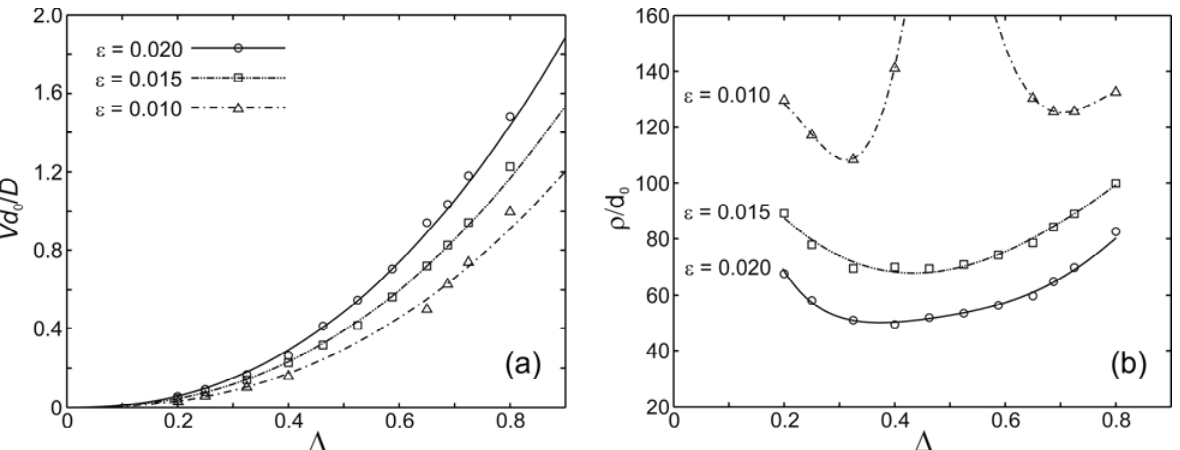
Figure 3. Calculated operating point parameter, σ *, as predicted by the phase field model as a function of undercooling and anisotropy strength. At ε = 0.01 stable dendritic growth is not observed in the undercooling range 0.4625  Δ  0.5875. Instead a